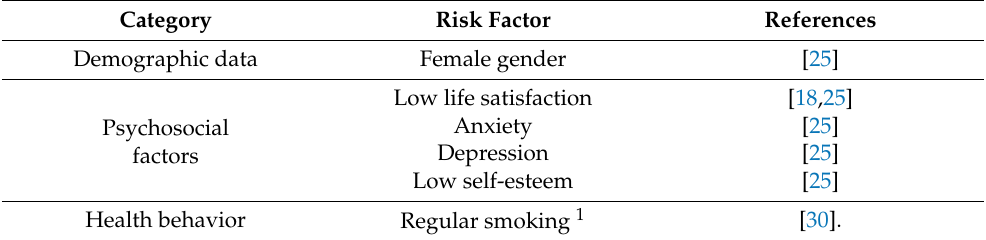
Table 3. Evidence-based risk factors for chronicity of non-specific back pain in children and adolescents.